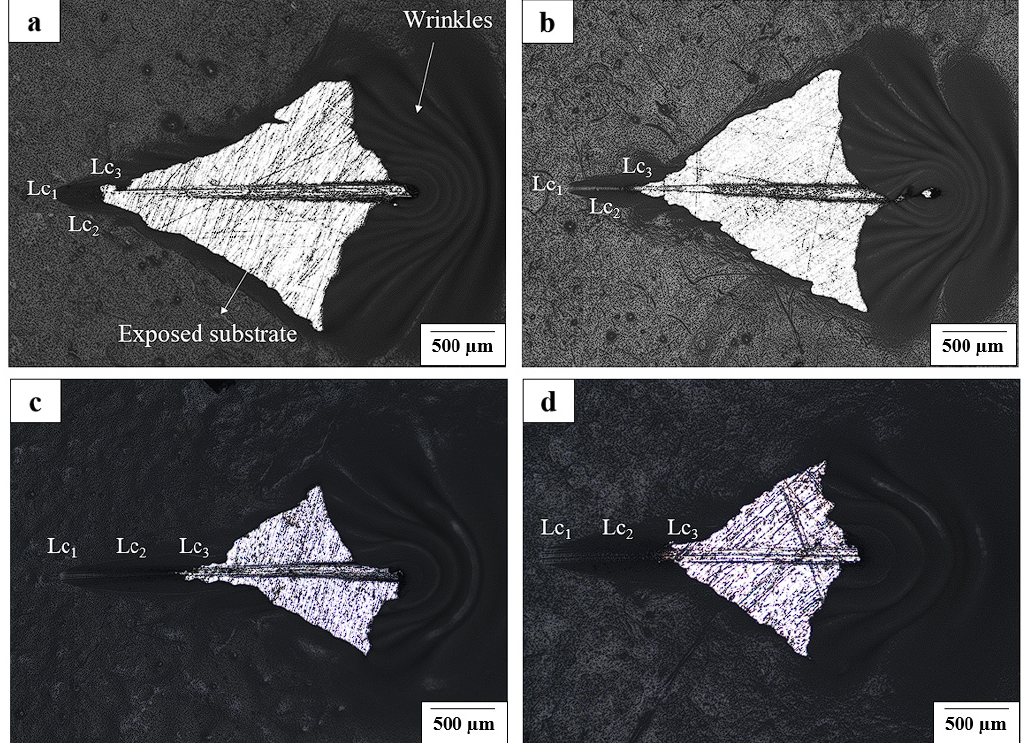
Figure 10. Optical microscopy of the scratch tracks performed on the coated surface ( a ) cp-Ti with polish treatment; ( b ) cp-Ti with acid etching treatment cp-Ti; ( c ) Ti-30Ta with polish treatment; ( d ) Ti-30Ta with acid etching treatment. Ti-30Ta: Lc 1 represents the first delamination of the coating; Lc 2 is the transition region of delamination and Lc 3 is the region where the damage is